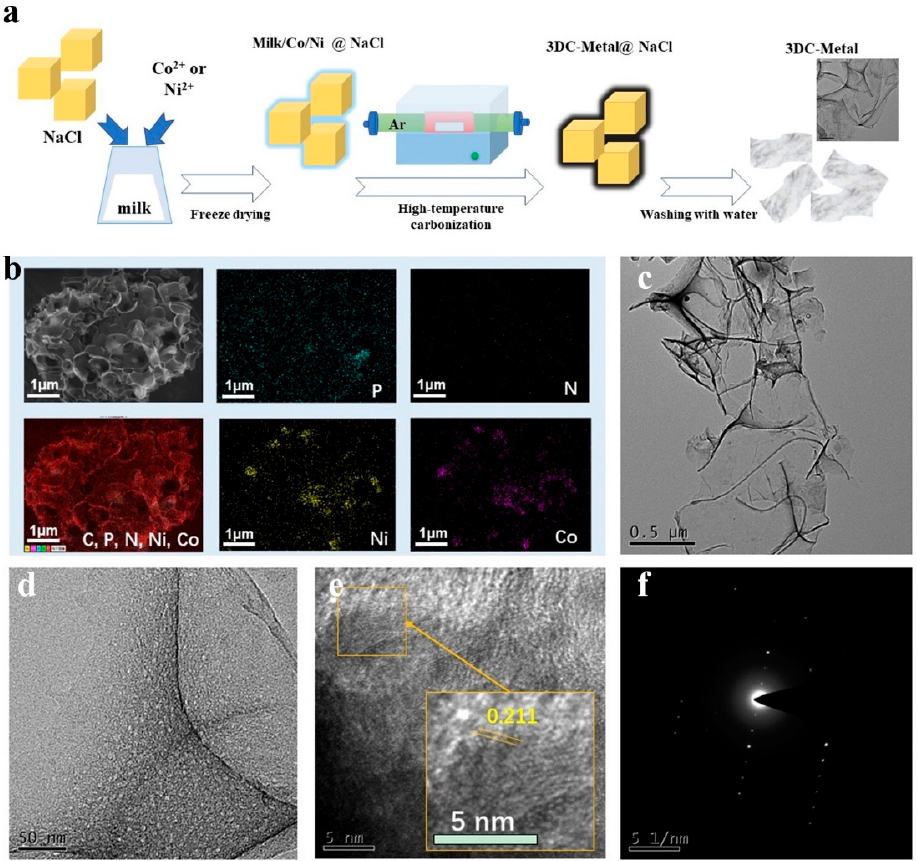
Figure 1. ( a ) Diagrammatic drawing of the synthetic process for 3D-C-metal, ( b ) SEM and elemental mappings, ( c , d ) TEM images of 3D-C-NiCo (1:1), ( e ) HR-TEM images of 3D-C-NiCo (1:1), and ( f ) SAED pattern of 3D-C-NiCo (1:1). The X-ray powder diffraction (XRD) pattern of the catalyst (Figures 2a and S2) shows diffraction peaks of the CoNi alloy at 44.5° (111), 51.5° (200) and 76.0° (220) [23]. It shows